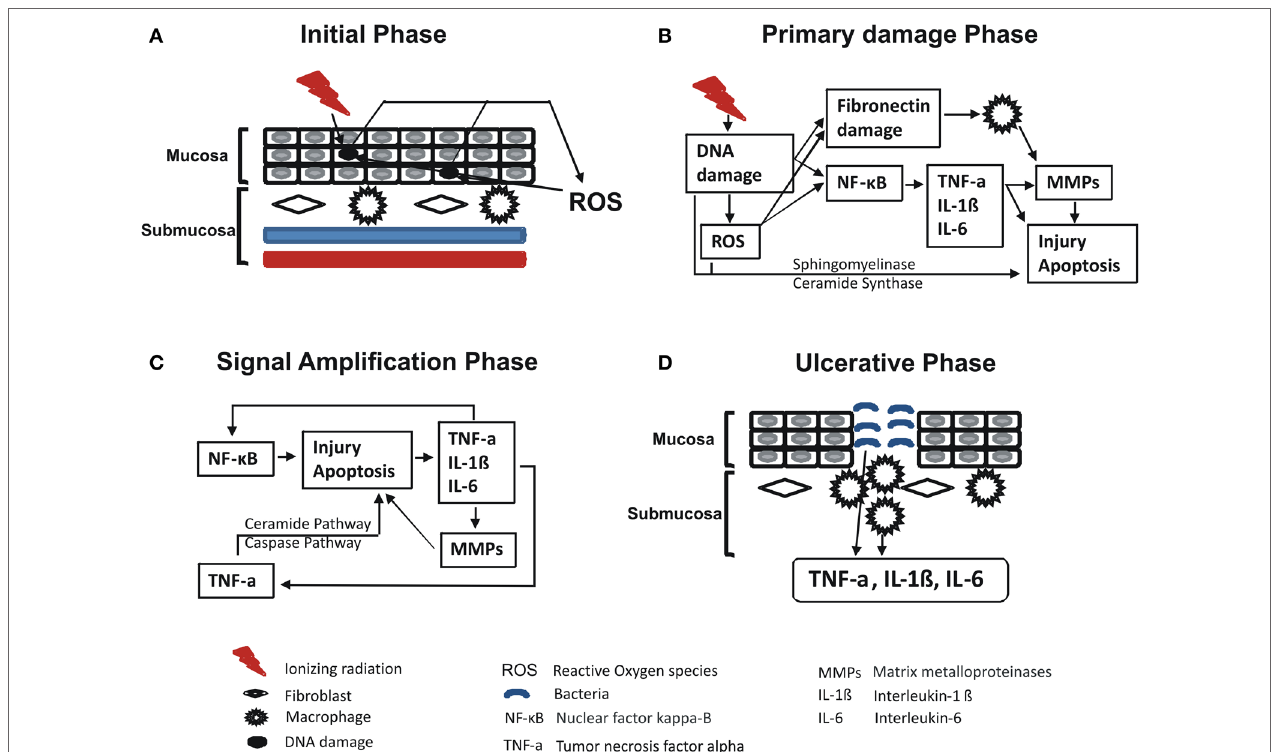
FiGuRe 2 | Redding’s summary of RT and/or chemotherapy (CT)-induced oral mucositis pathobiology (11) . Redding has summarized the pathobiology phases of radiation-induced oral mucositis induced by RT and/or CT. In brief, initiation phase with RT and/or CT results in direct and lethal DNA damage, which leads to release of reactive oxygen species (ROS) from epithelial, vascular endothelial, fibroblasts, and tissue macrophages with cycles of amplifications. Within such primary damage response, the DNA damage and ROS lead to three major steps: (1) fibronectin breakdown that activates macrophages ending with stimulation